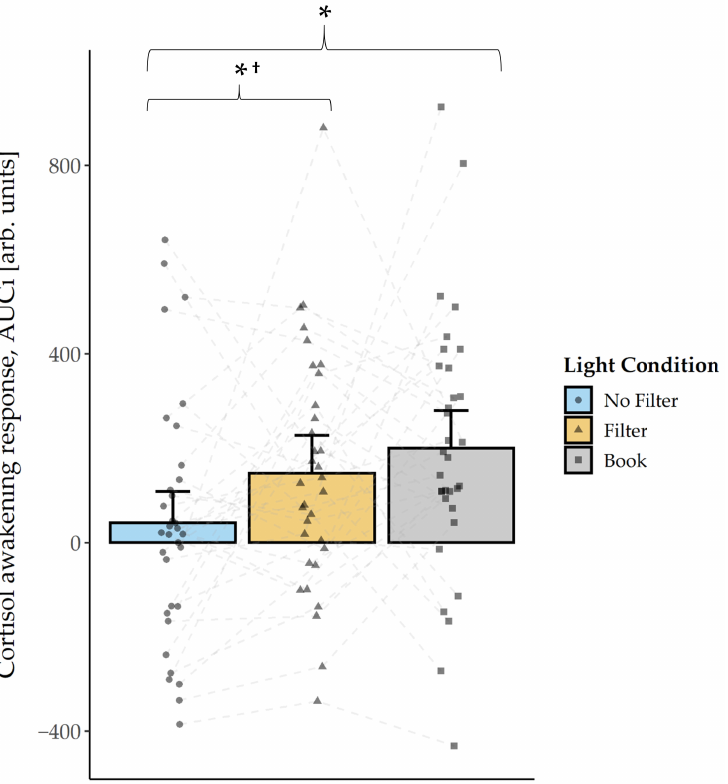
Figure 2. Cortisol awakening response (mean and 95% confidence intervals). The AUCi was calculated for three time points in the morning, i.e., at awakening as well as 30 min and 60 min after awakening. AUCi was significantly smaller in the “no filter” compared to both other light conditions. The dashed lines connect the measurements from each subject. *: p ≤ 0.05; †: p adj . >